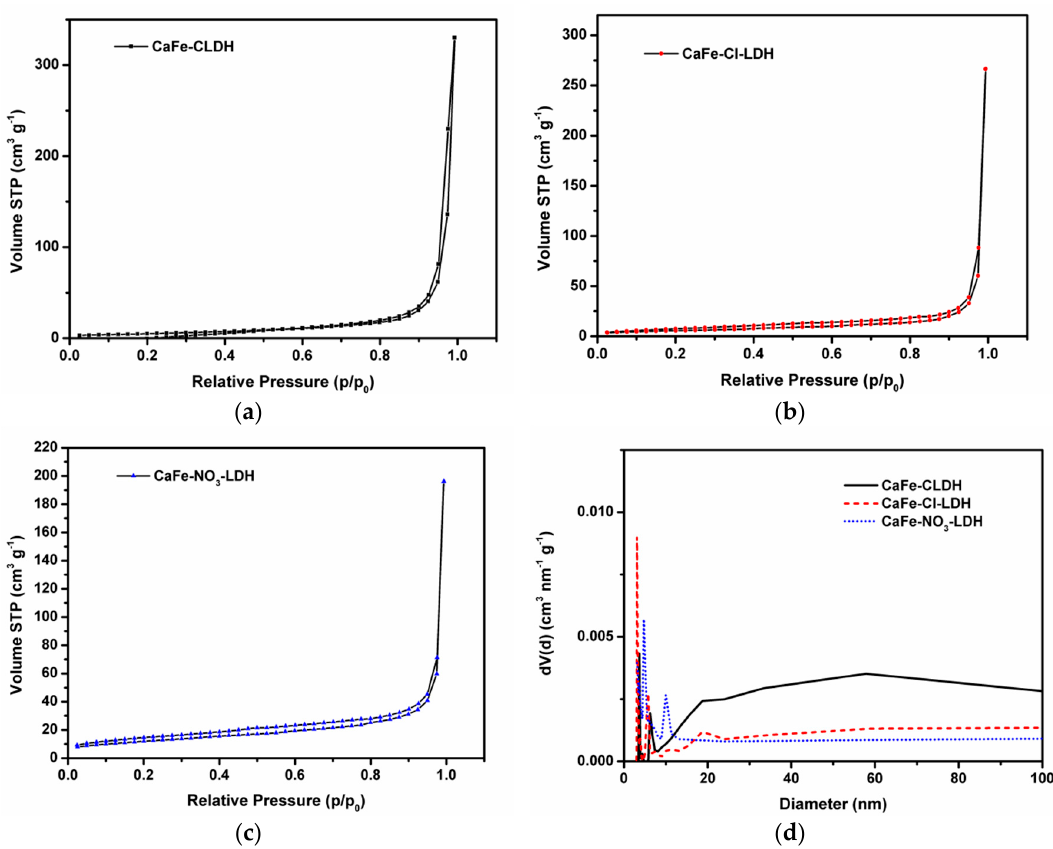
Figure 2. ( a ) N 2 adsorption/desorption isotherms of CaFe-CLDH. ( b ) N 2 adsorption/desorption isotherms of CaFe-Cl-LDH. ( c ) N 2 adsorption/desorption isotherms of CaFe-NO 3 -LDH. ( d ) Pore size distribution of three materials (Brunauer-Joyner-Hallenda, BJHmethod). Table 1. The specific surface area of the synthetic material, the average pore size, and the total pore volume.